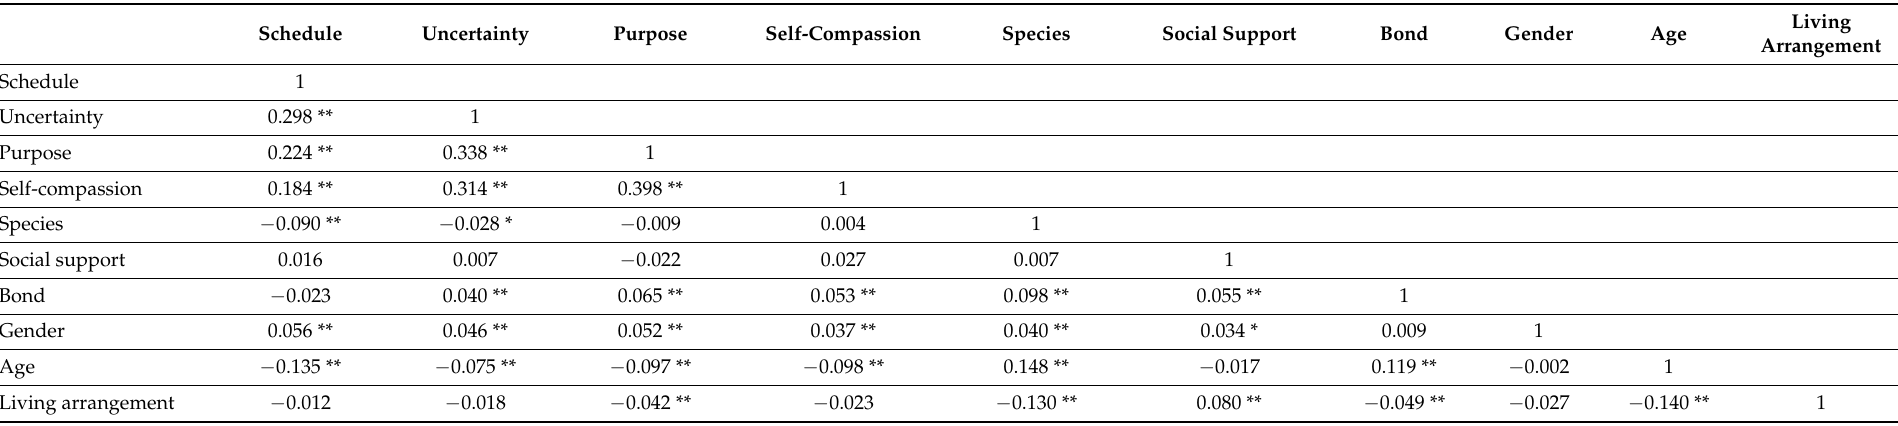
Table 5. Correlation matrix of positive emotions and potential predictive variables: social support, species, age, gender, bond, and living